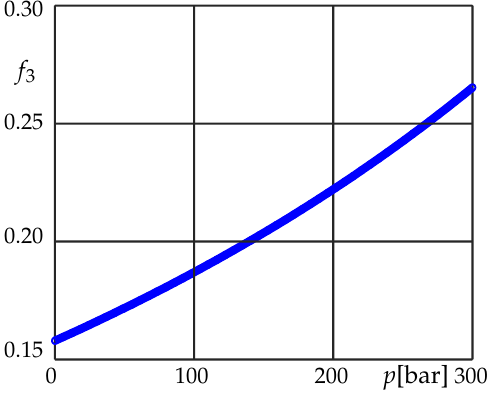
Figure 6. Permeability correction factor f 3 versus gas pressure with m = 0.5, α B = 0.5, E a = 180 MPa, σ n = 38 MPa, and α B = 0.5.